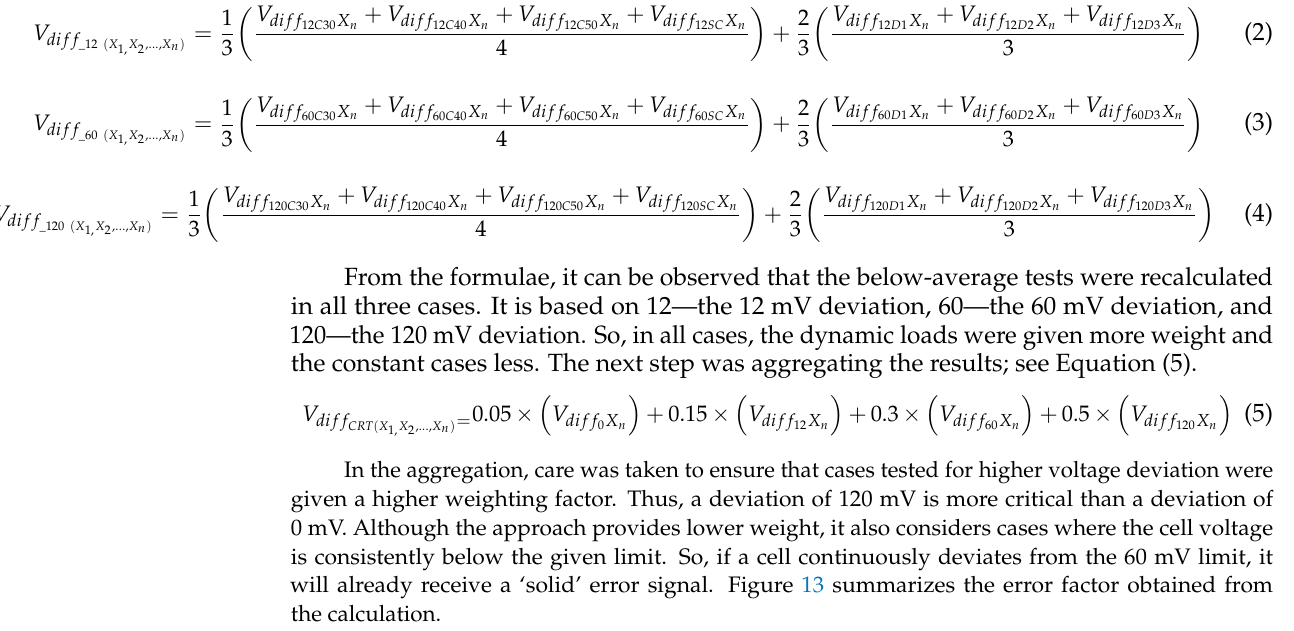
88 In Table 1, the numbers in columns indicate the order of the cycle, which data were retrieved during the tests. The numbers are the cell IDs, and the total voltage with load current is retrieved in each cycle. Considering the acceleration capability of the car, the